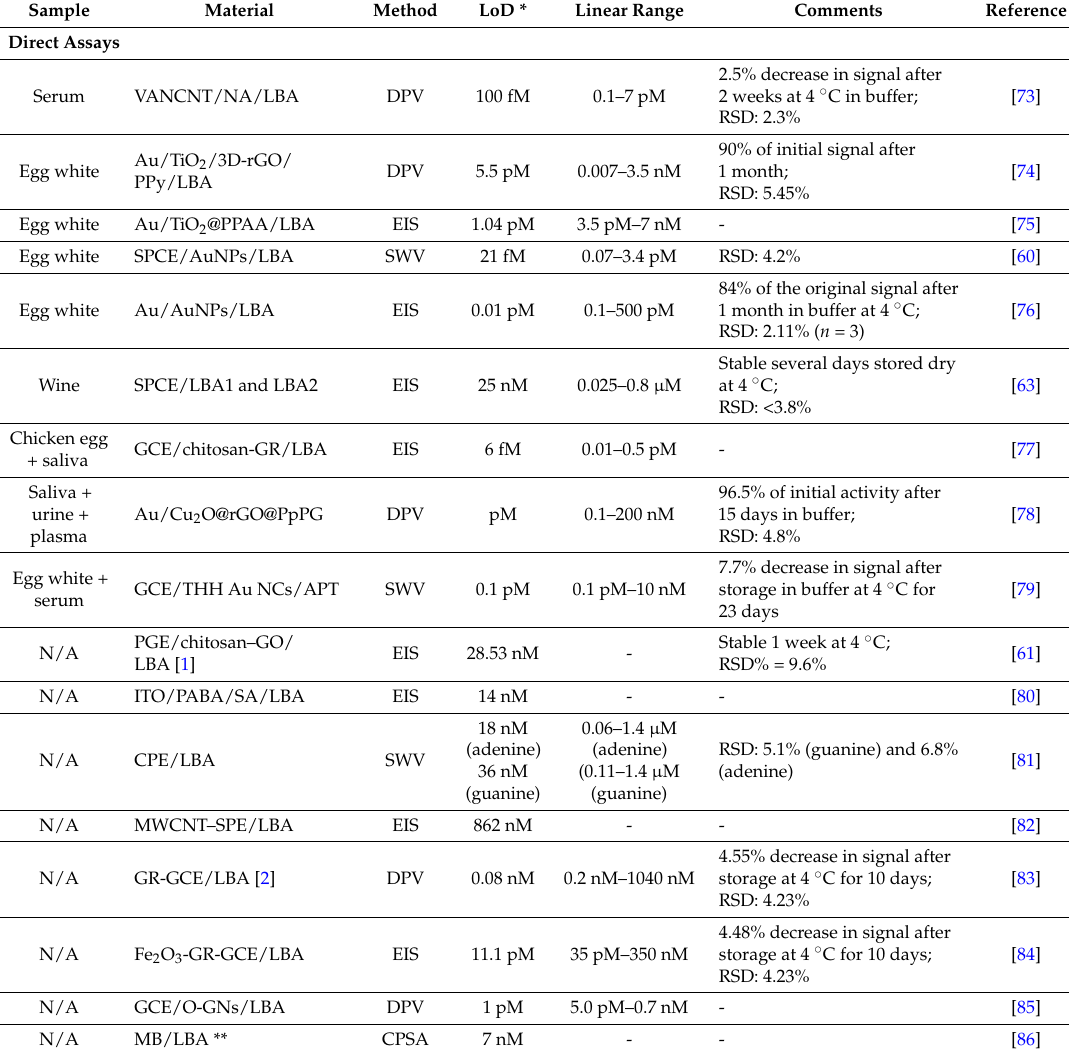
Table 2. Electrochemical aptasensors developed for lysozyme